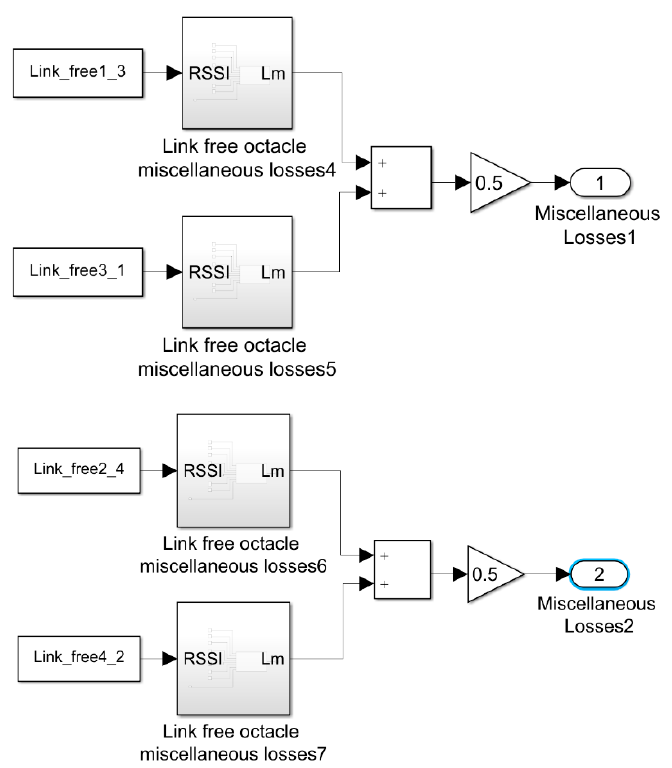
Figure 14. Miscellaneous losses calculation subsystem.